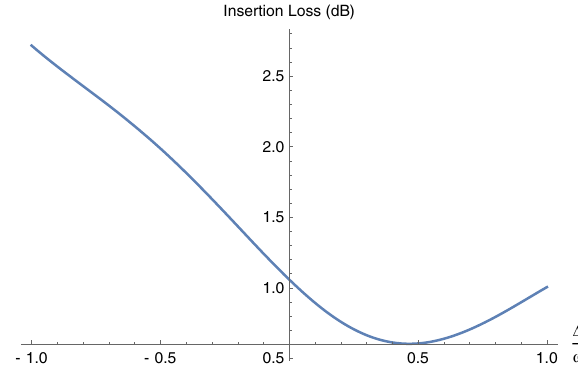
Fig. 6 Illustration of insertion loss for the proposed